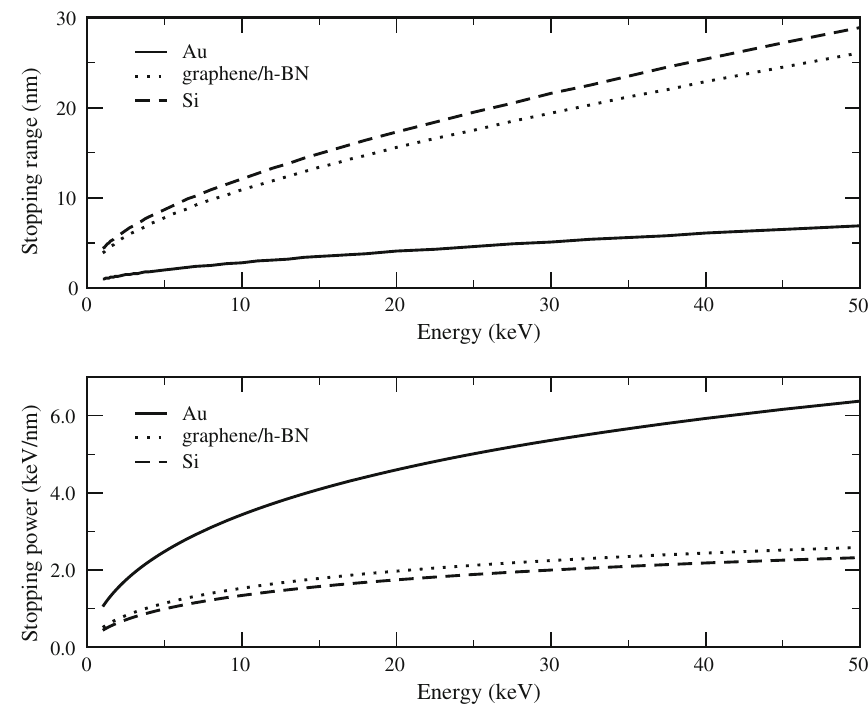
Fig. 2 Plot of SRIM simulated stopping range (top) of, and stopping power (bottom) for, a Au nucleus in Au, graphene/h-BN heterostructure, and Si as a function of Au nucleus energy. The simulations for the graphene/h-BN heterostructure were done by approximating the heterostructure by a compound of C, B, and N with a stoichiometric ratio of